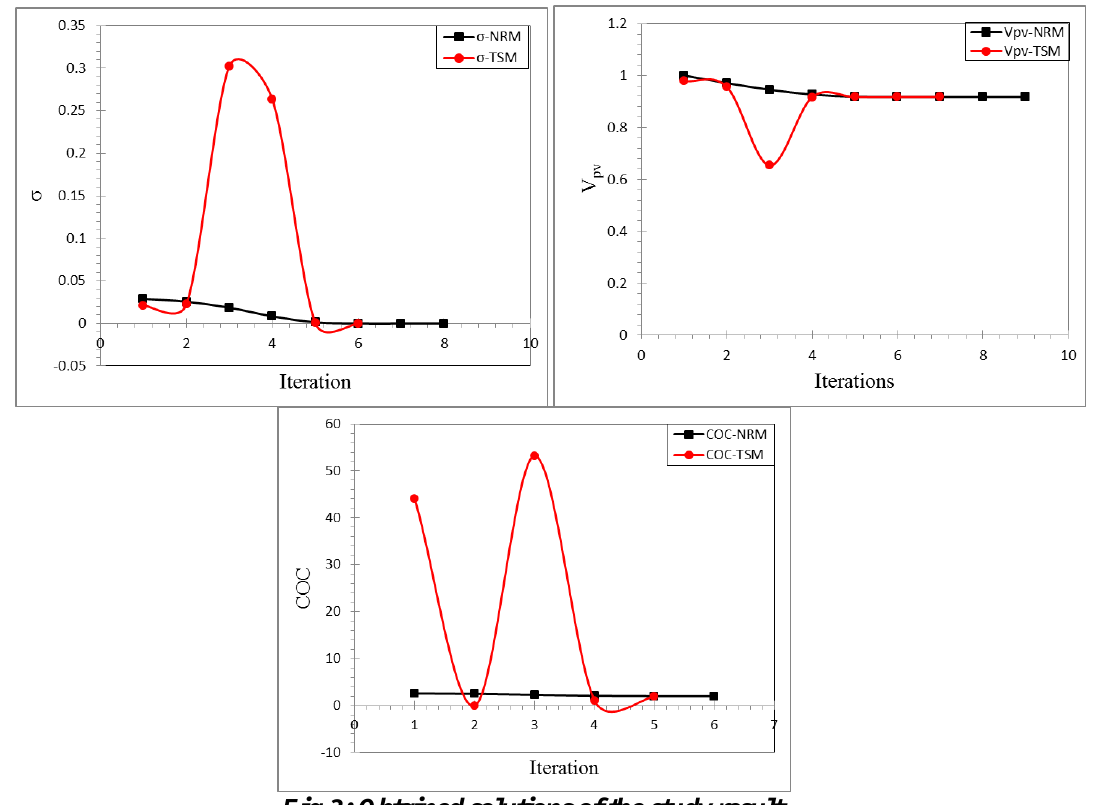
Fig.3: Obtained solutions of the study result.